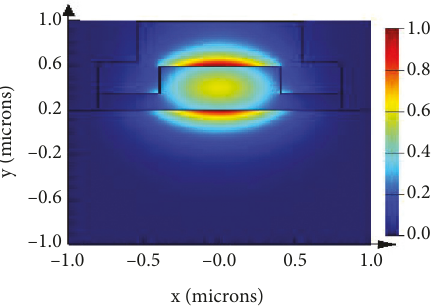
Figure 2: Rib waveguide with